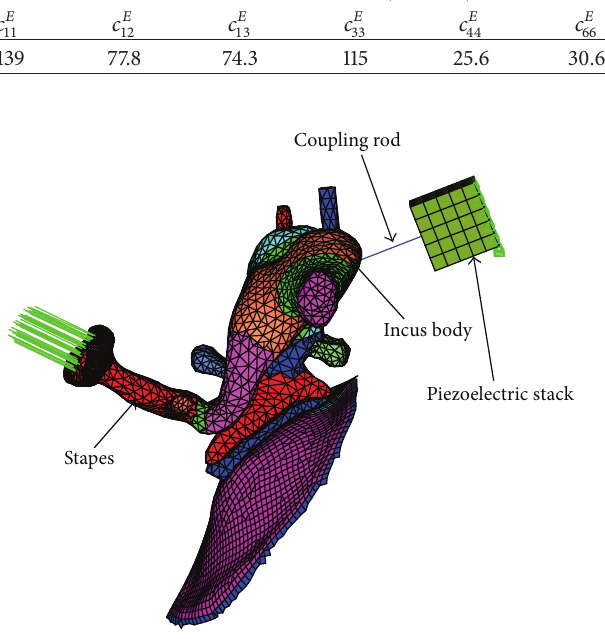
Figure 3: Coupling mechanical model of the piezoelectric stack transducer and the middle ear.